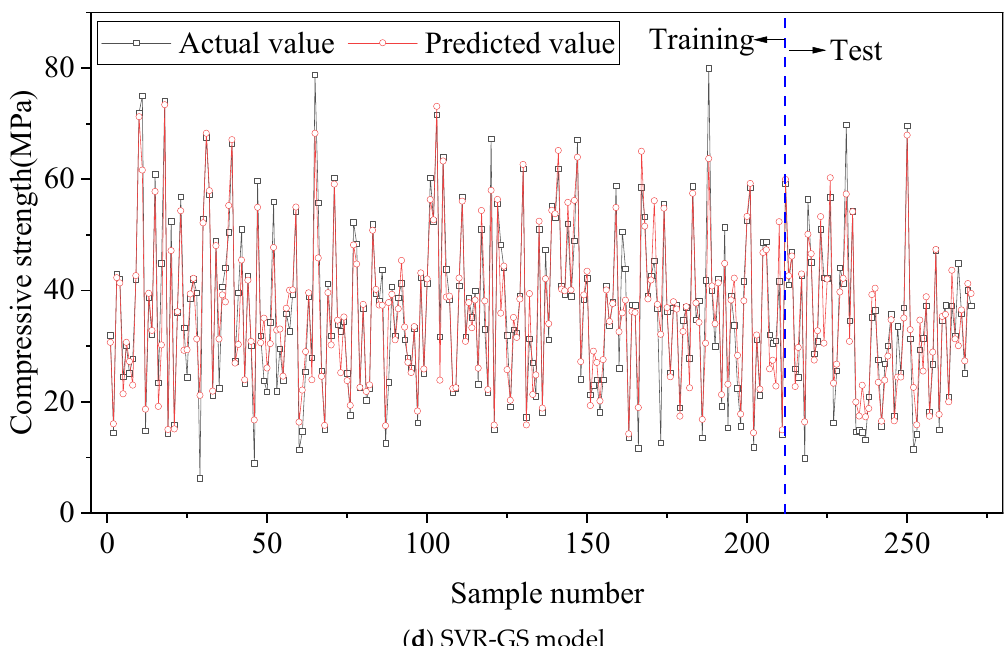
Figure 8. The training and test results of the models.